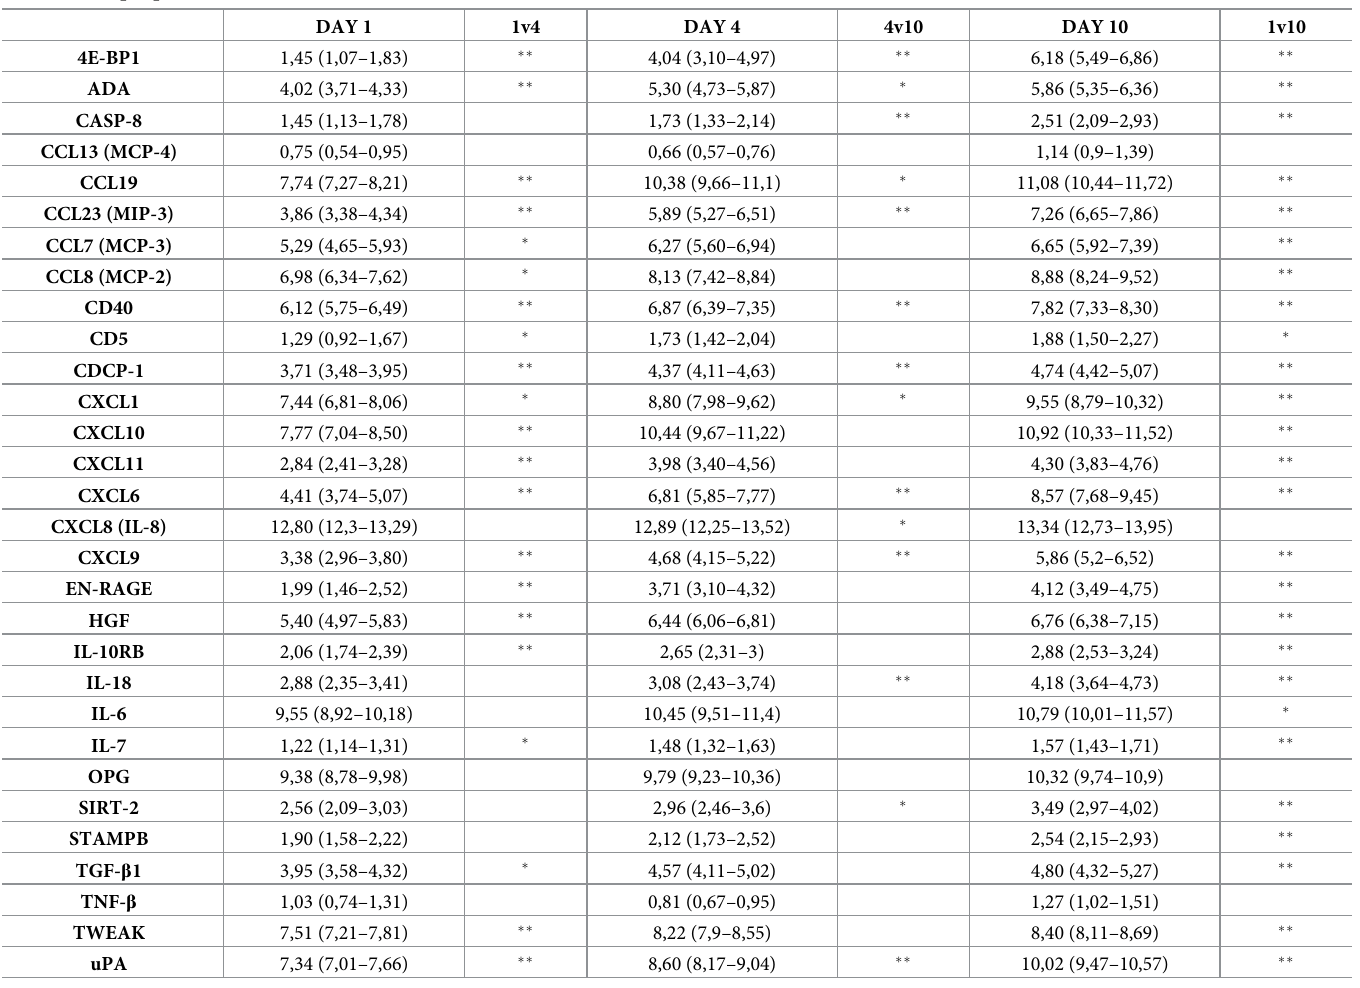
Table 5. Group C